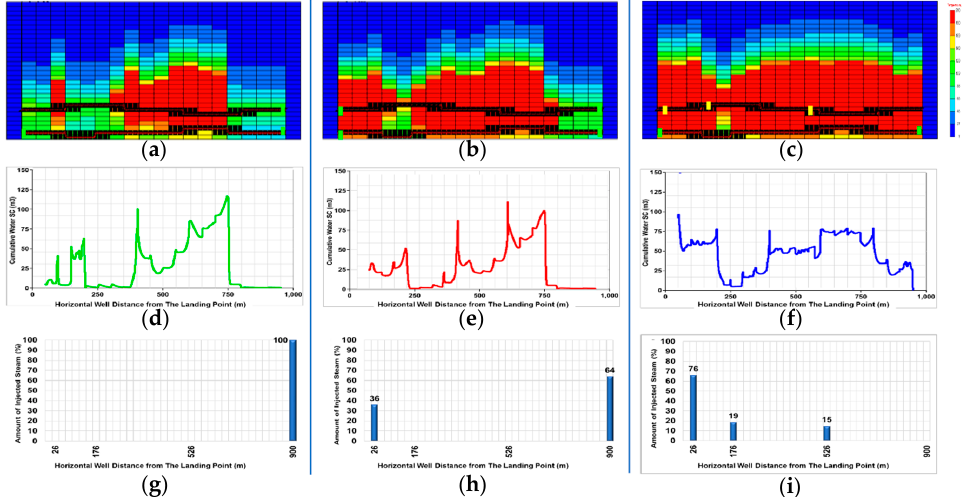
Figure 14. Distribution of injected steam at different points after one year of SAGD. ( a ) Temperature map (single tubing); ( b ) temperature map (dual-string); ( c ) temperature map (OCDs); ( d ) cumulative